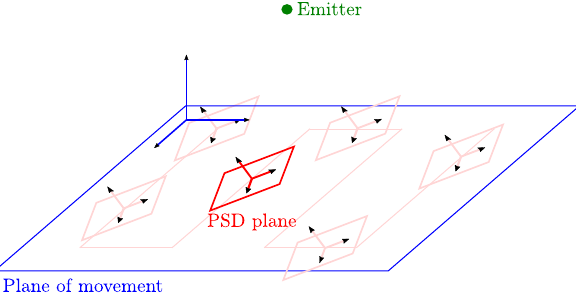
Figure 1. Relative position between the plane of movement and the plane of the